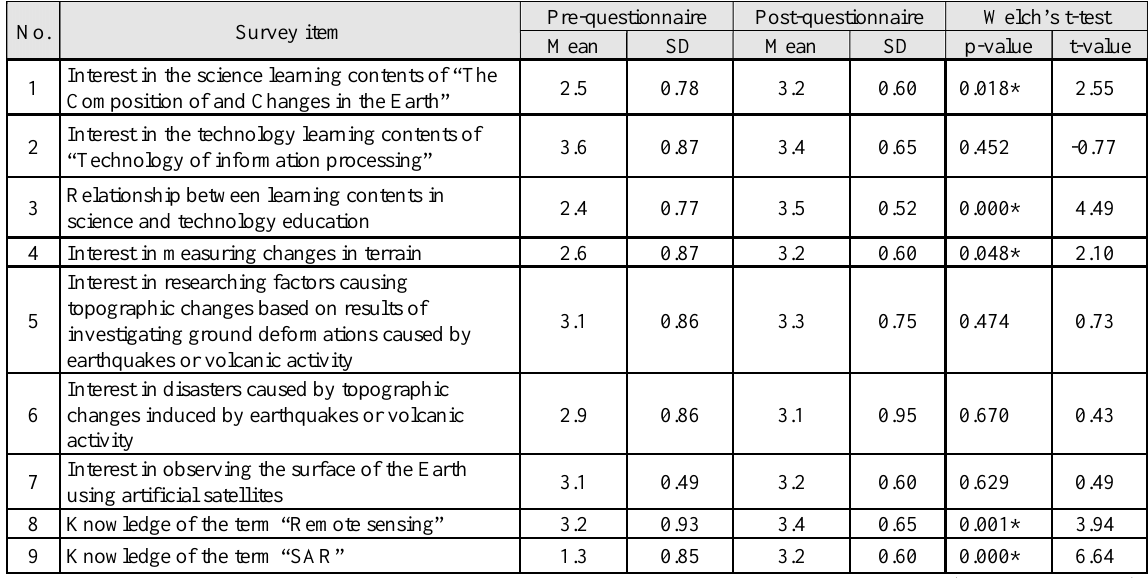
Table 3. Results of pre- and post- questionnaire surveys and statistical